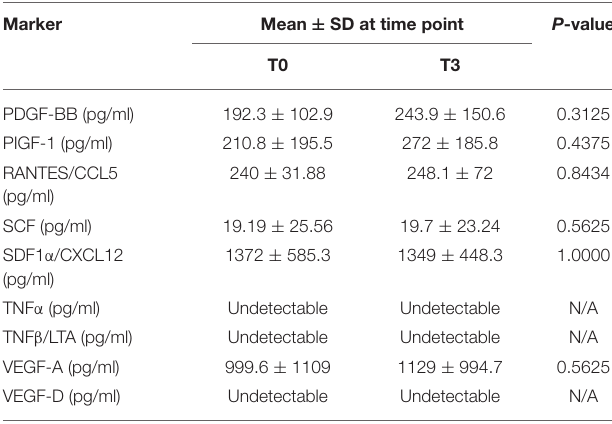
TABLE 3 | Soluble inflammatory